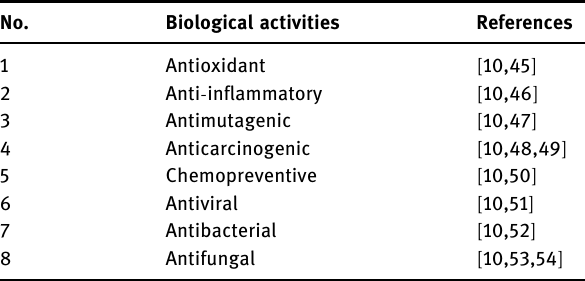
Table 1: Di ff erent biological activities of selenium which makes it most preferable for the biosynthesis of nanoparticles No. Biological activities